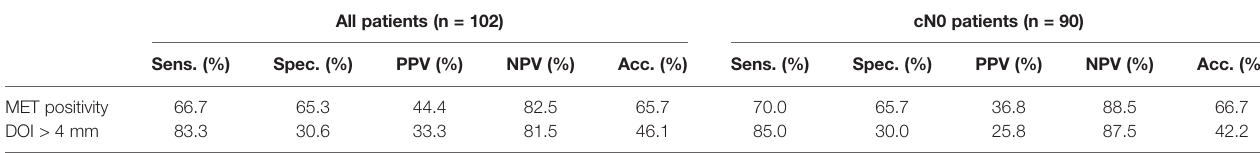
TABLE 4 | Sensitivity, speci fi city, PPV, and NPV and accuracy of MET positivity and DOI > 4 mm with respect to pN+ for all cancers (n=102) and cN0 cancers (n=90). All patients (n = 102)